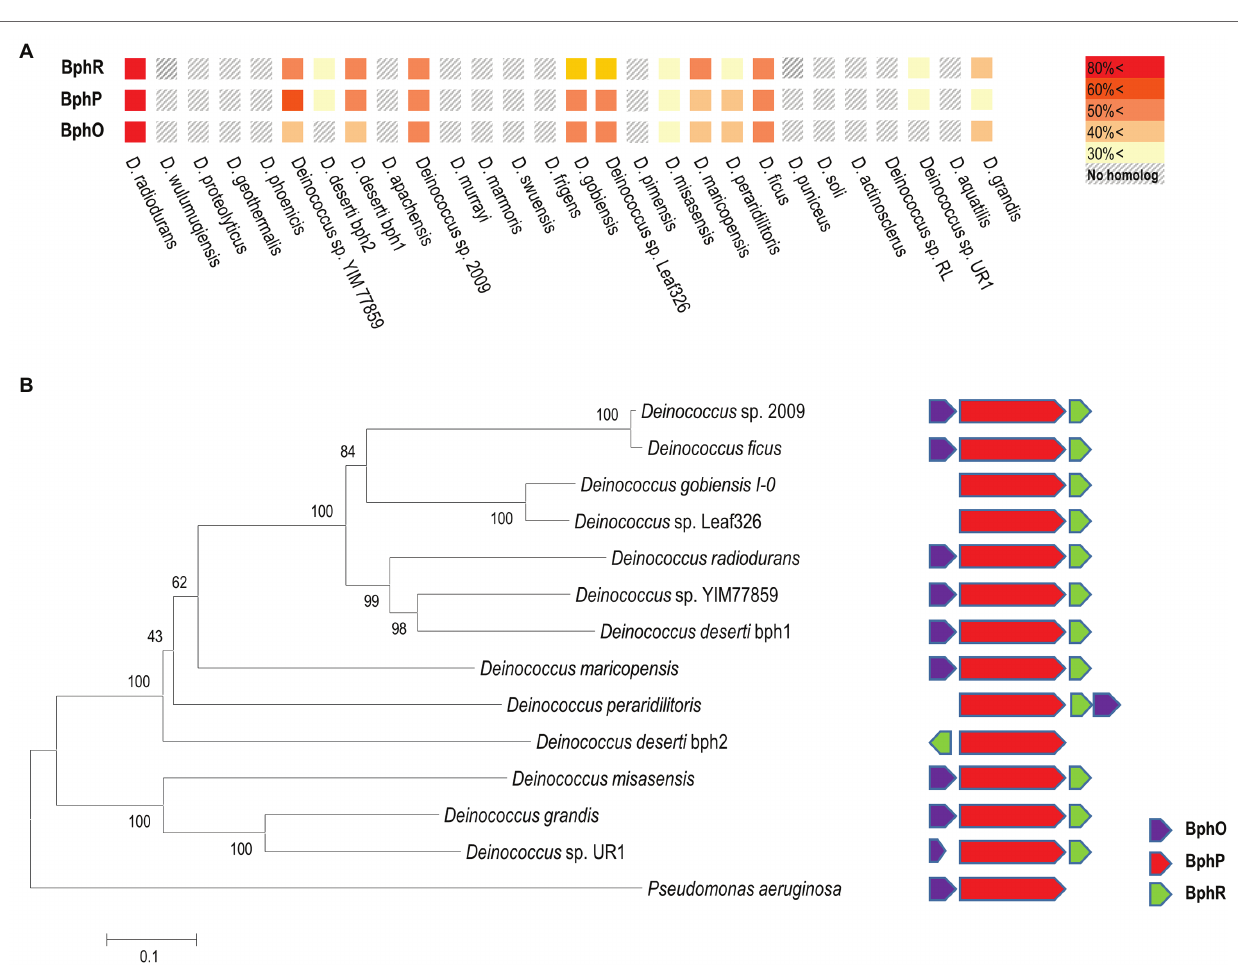
FIGURE 7 | Distribution of the Bph proteins among several Deinococcus species. Amino acid sequences of Bph proteins were obtained from the genomes of 27 Deinococcus strains in the NCBI database, and sequence homology analysis was performed using BLAST. Colors in the heat map represent homology between Bph proteins, when compared to the D. radiodurnas BphR, BphP, and BphO proteins, respectively (A) . The phylogenetic analysis was carried out using a protein sequence alignment of 13 deinococcal BphP and Pseudomonas aeruginosa BphP proteins completed in Clustal omega. The phylogenetic tree was developed using the neighbor-joining algorithm in MEGA 6.0, and the scale indicates the number of amino acid substitutions per site. All the node numbers represent the bootstrap value based on 1,000 replications (left side panel in B ). Comparison of the gene order of related bph operons (right side panel in B